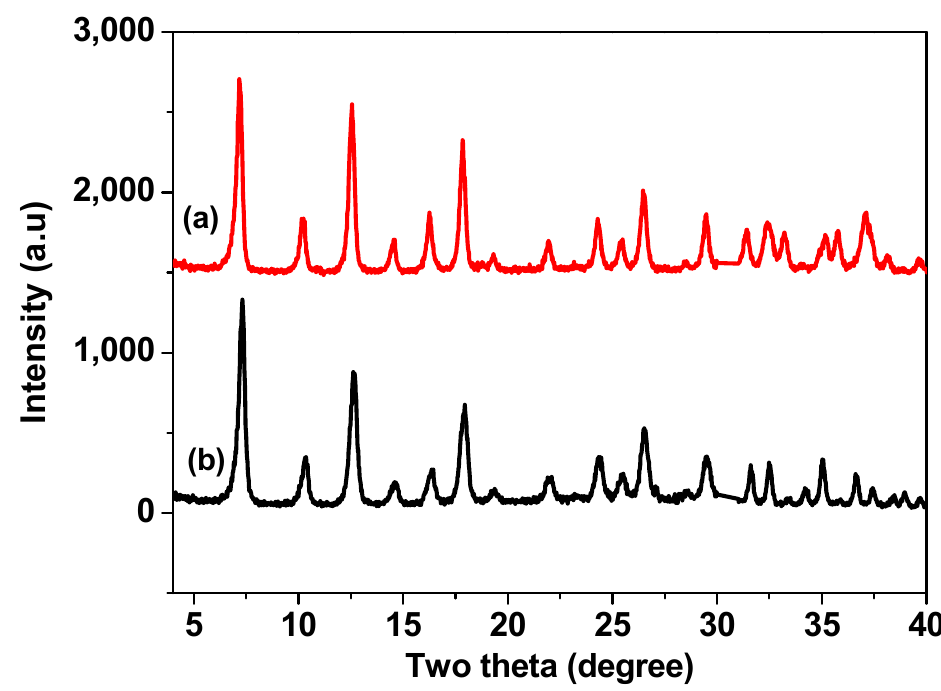
Figure 3. XRD patterns of fresh ZIF-8 (a) and recovered ZIF-8 after treatment in water (b).